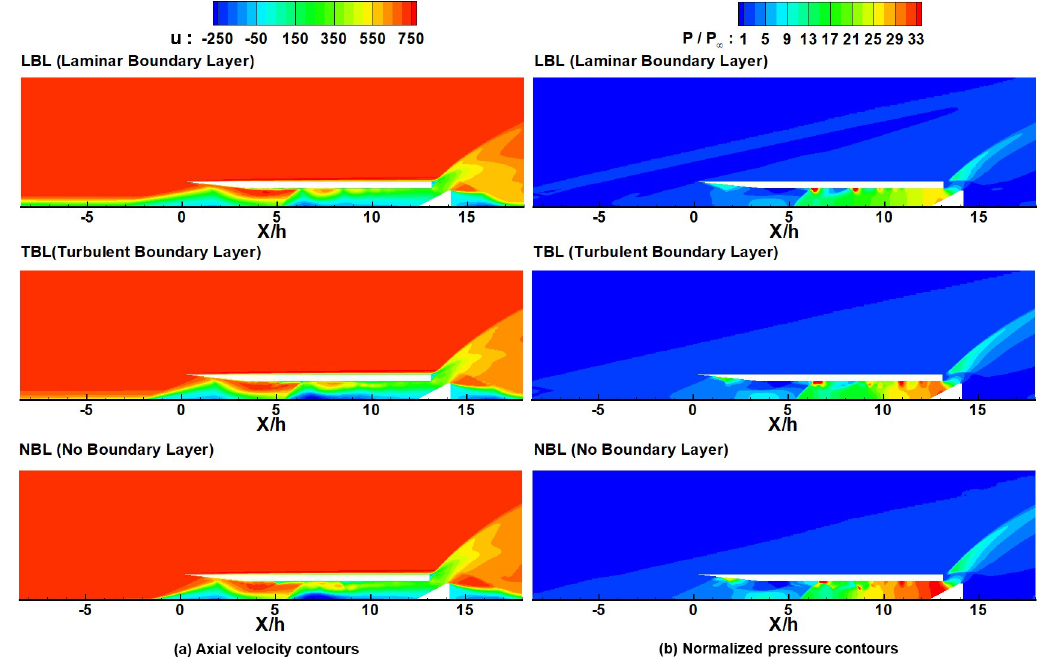
Fig 14. Velocity contours and normalized pressure contours at t = 21.8 msec for different boundary layer cases. (a) Axial velocity contours. (b) Normalized pressure contours.